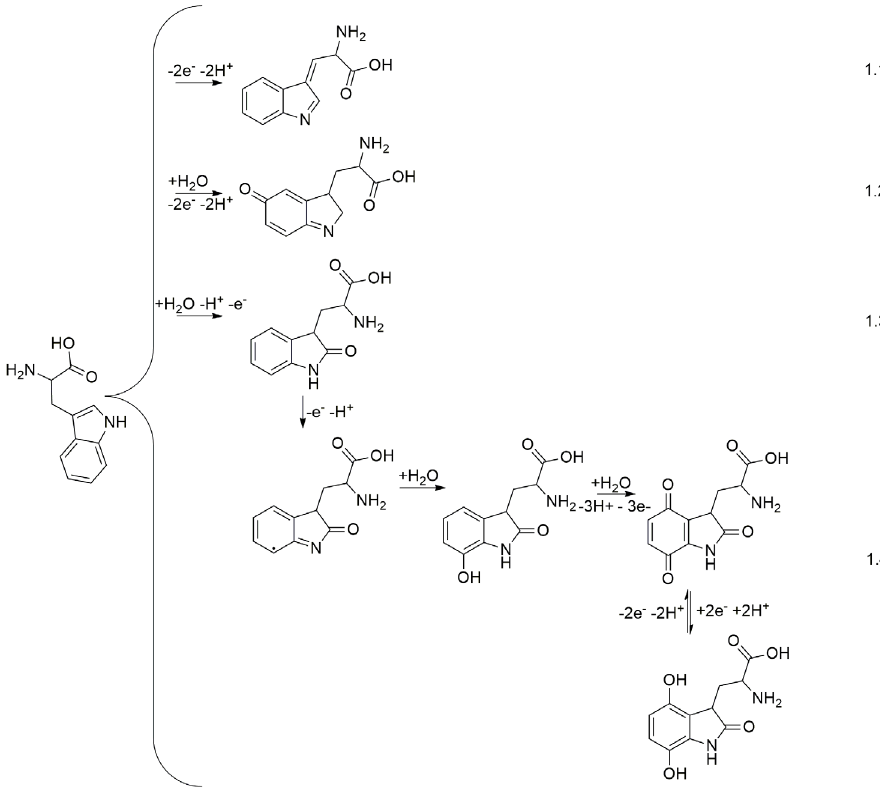
Figure 2 - Oxidation pathways of L-Trp as proposed in the literature by several authors. 1.1 (Suprun et al. 2013), 1.2 (Zhu et al. 2014), 1.3 (Malfoy and Reynaud 1980) and 1.4 (Enache and Oliveira- Brett